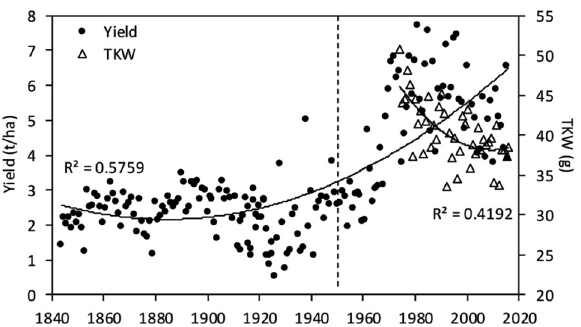
Figure 1. Trends in wheat yield and thousand kernel weight (TKW) of Broadbalk experiment from 1850 to 2016. Data are means. The dashed line represents the introduction of dwarf cultivars in